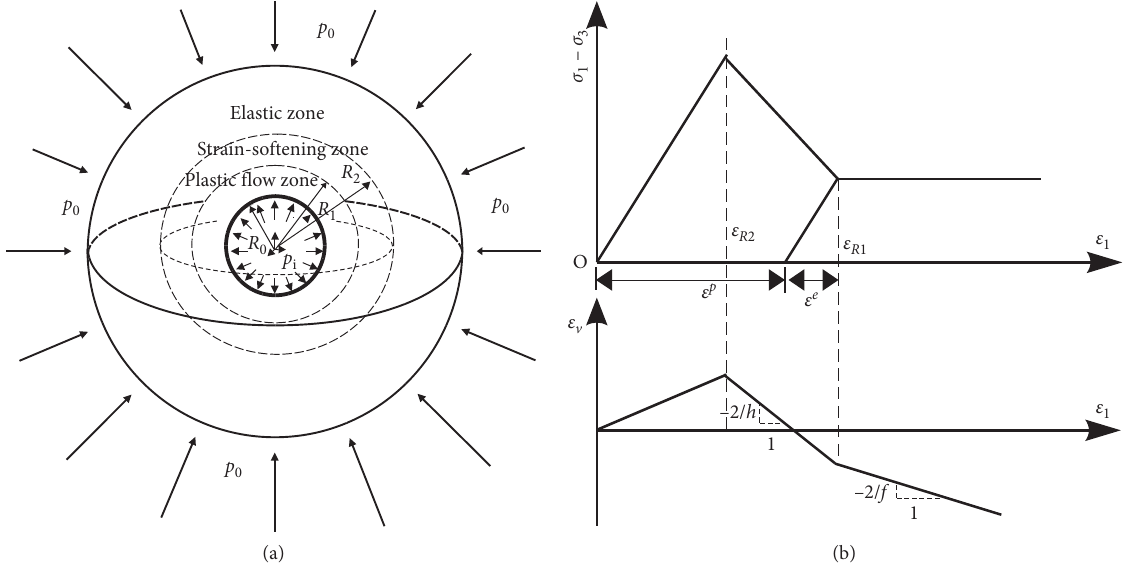
Figure 1: Elastoplastic model of spherical salt cavern. (a) Sketch of salt cavern deformation zones. (b) Simplified model of salt rock with strain-softening behavior.